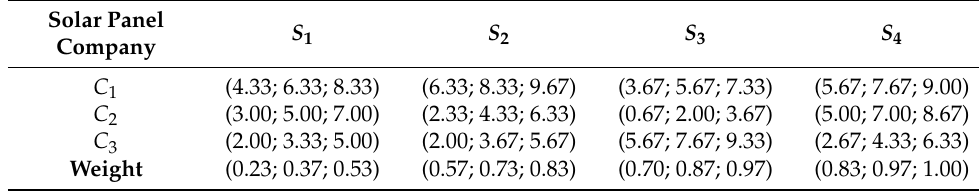
Table 10. Fuzzy decision matrix for M 2 .